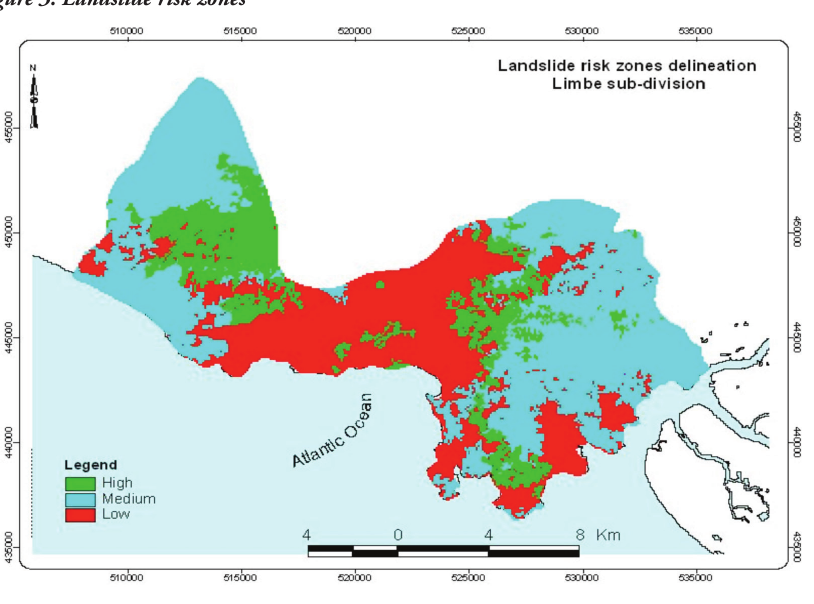
Figure 3: Landslide risk zones